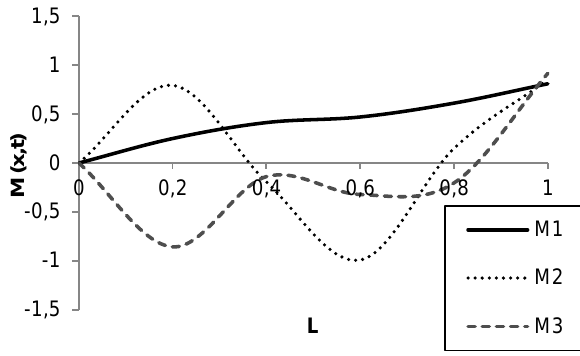
Figure 9: Dimensionless frequency vs. dimensionless amplitude for various for various electric voltages. ( L / h = 20 , K w = K p = 30 , ∆T = 20 ∘ , α = 0.5 )